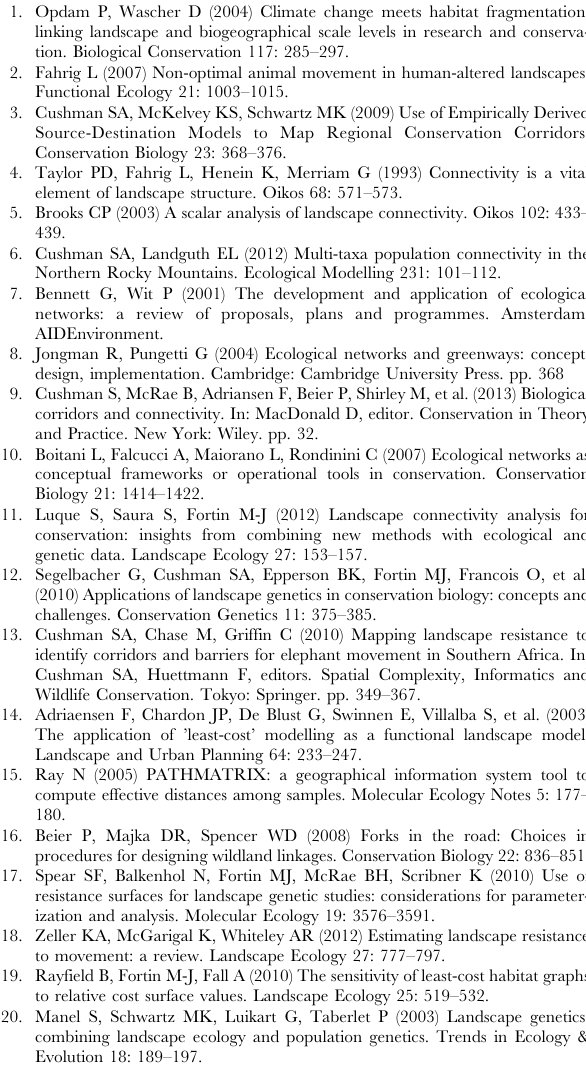
Table S3 Results of causal modeling of landscape resistance on genetic distance in European pine marten according to Mantel and partial mantel tests for the untransformed